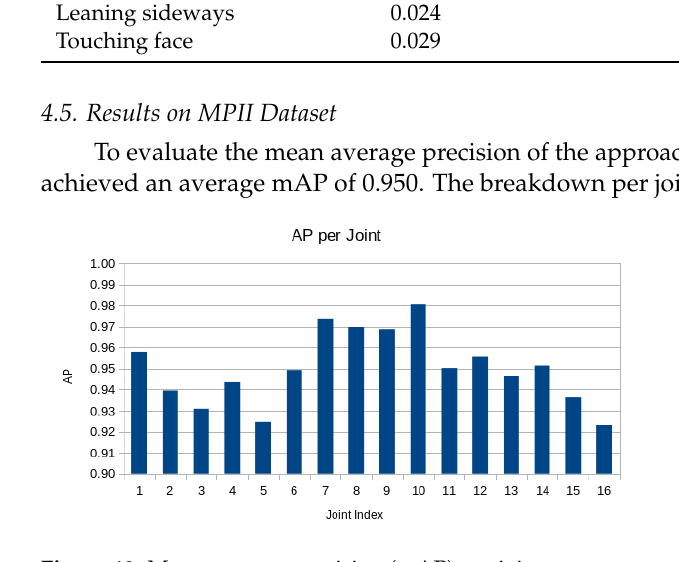
Figure 13. Mean average precision (mAP) per